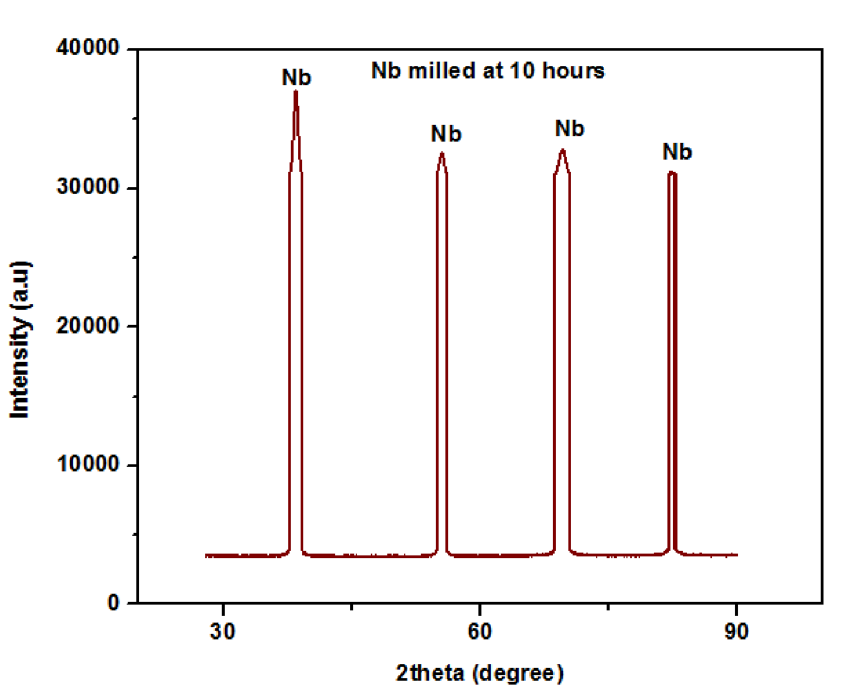
Figure 2. XRD diffraction pattern of the milled Nb powder.